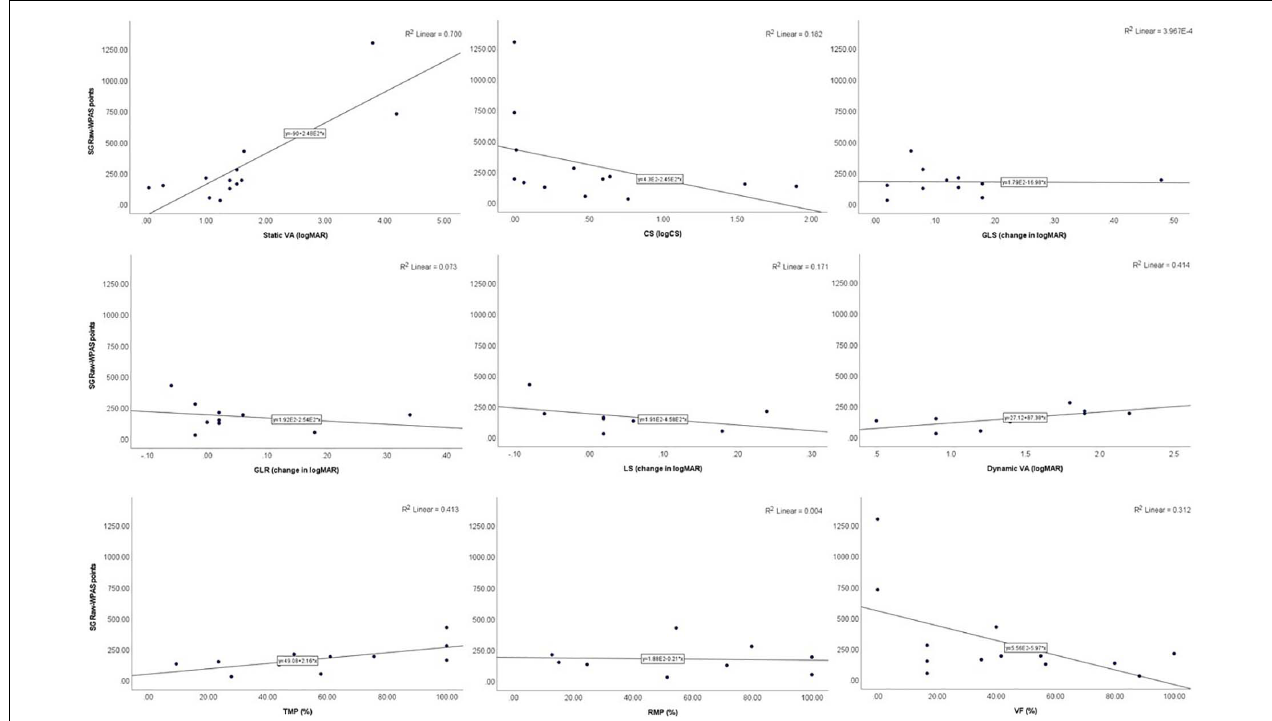
FIGURE 5 | Scatter plots showing the relationships between SG raw-WPAS points and visual